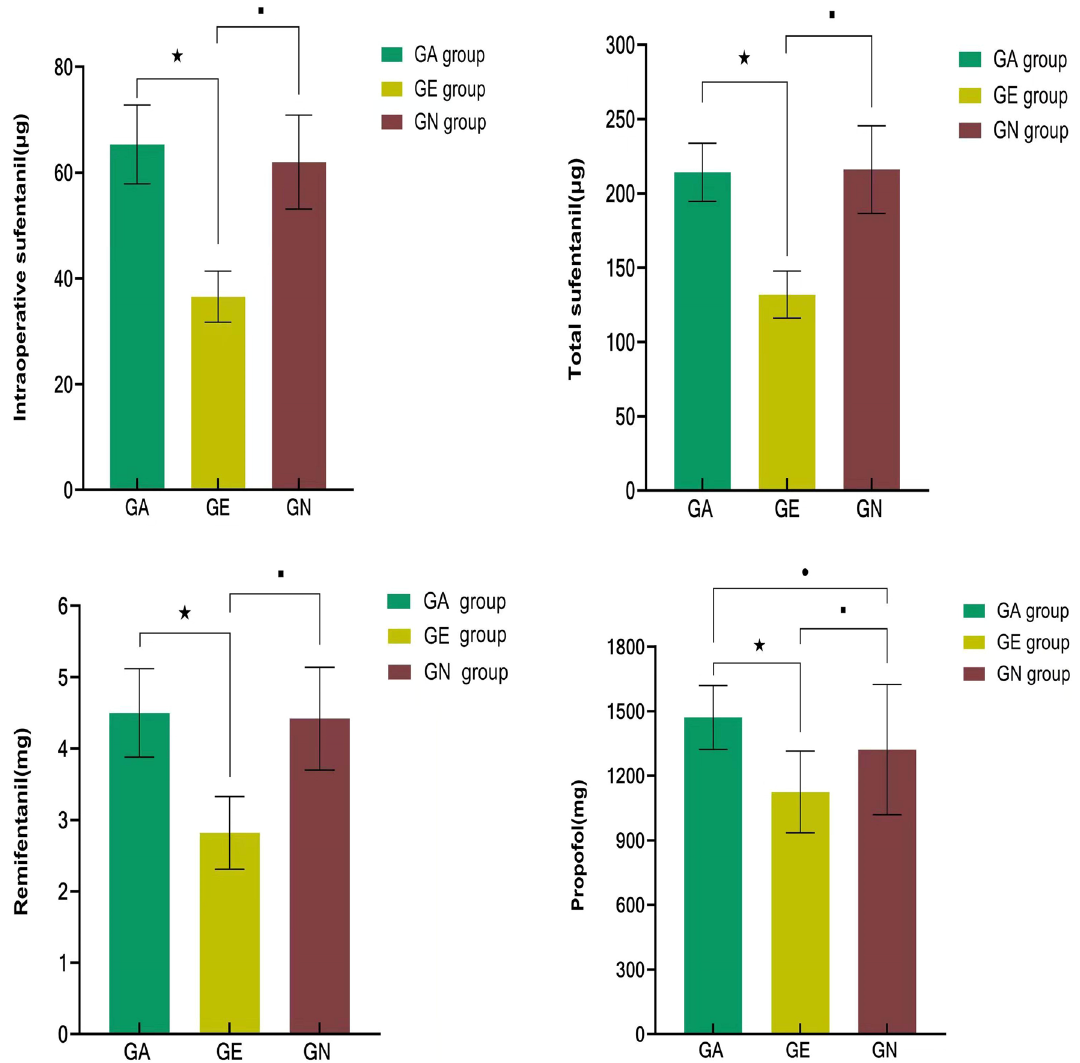
Figure 3. Comparison of the dosage of anesthetics among the three groups. ★ : Compared with the GA group, P < 0.05; ■ : Compared with the GE group, P < 0.05; ● : Compared with the GN group, P <